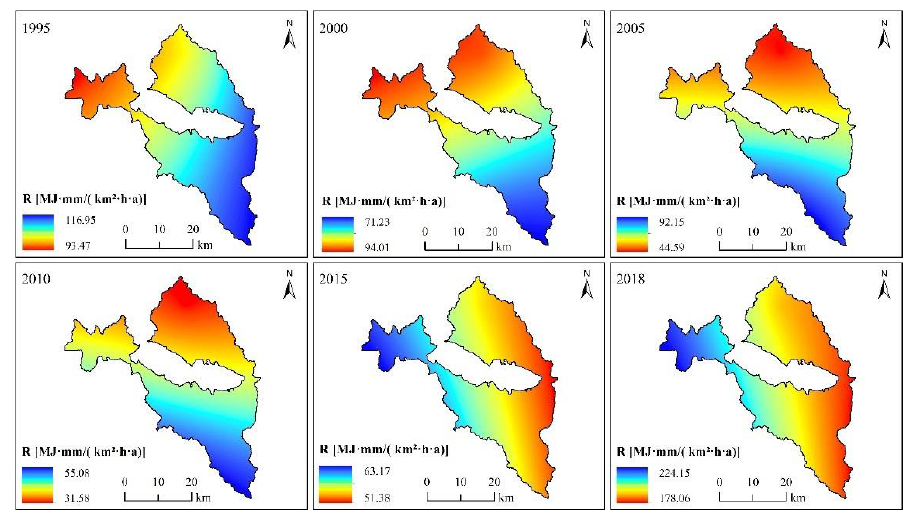
Figure 2. Spatial distribution of rainfall erosivity in the South and North Mountains of Lanzhou in 1995, 2000, 2005, 2010, 2015 and 2018. 1995, 2000, 2005, 2010, 2015 and 2018.